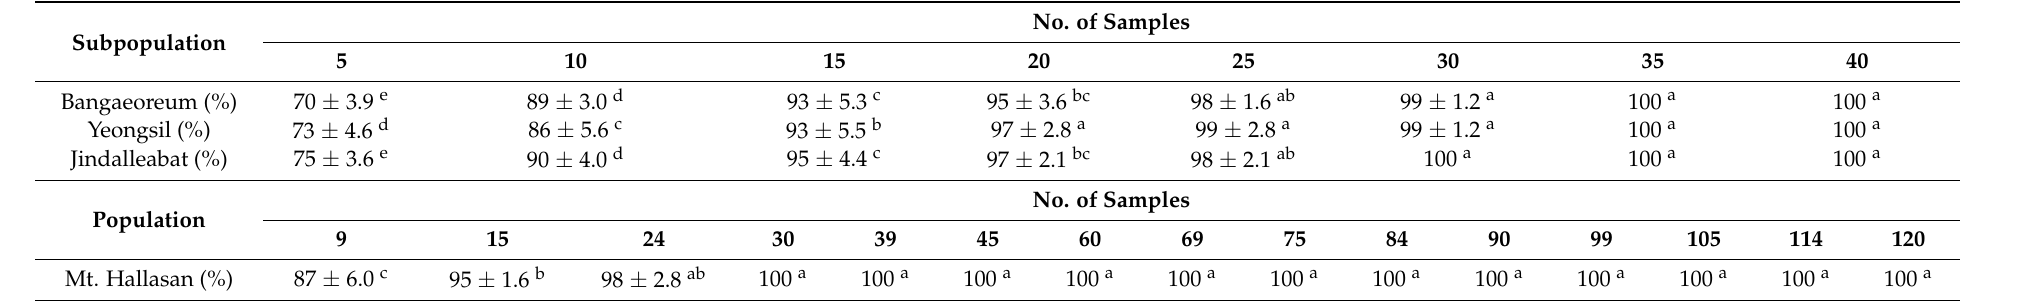
Table 6. Comparison of allele numbers with frequency ≥ 0.05 in Abies koreana population on Mt. Hallasan according to the sample size extracted based on